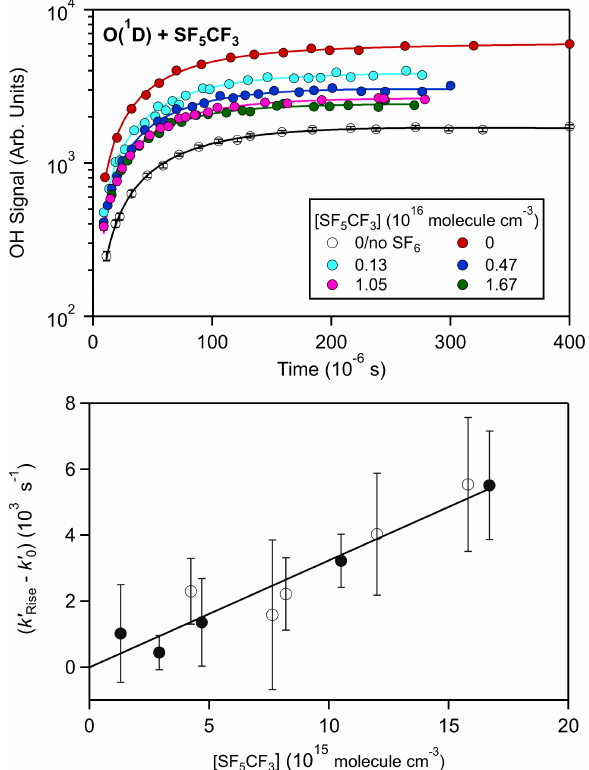
Fig. 4. Top Panel: Representative OH temporal profiles mea- sured for the O( 1 D) + SF 5 CF 3 reaction at 296K. The 2 σ error bars on the data points are from the measure- ment precision. The experimental conditions were 40Torr (He) total pressure, [O 3 ] = 3.4 × 10 12 moleculecm − 3 , [ n - C 4 H 10 ] = 1.9 × 10 13 moleculecm − 3 , ∼ 2Torr SF 6 , and [SF 5 CF 3 ] given in the legend. The lines are non-linear least-squares fit to the data. Lower Panel: Total rate coefficient data from two independent experiments. The error bars are the precision of the fits as shown in the top panel. The line is the linear least-squares fit to the data. The obtained rate coefficient is given in Tables 2 and